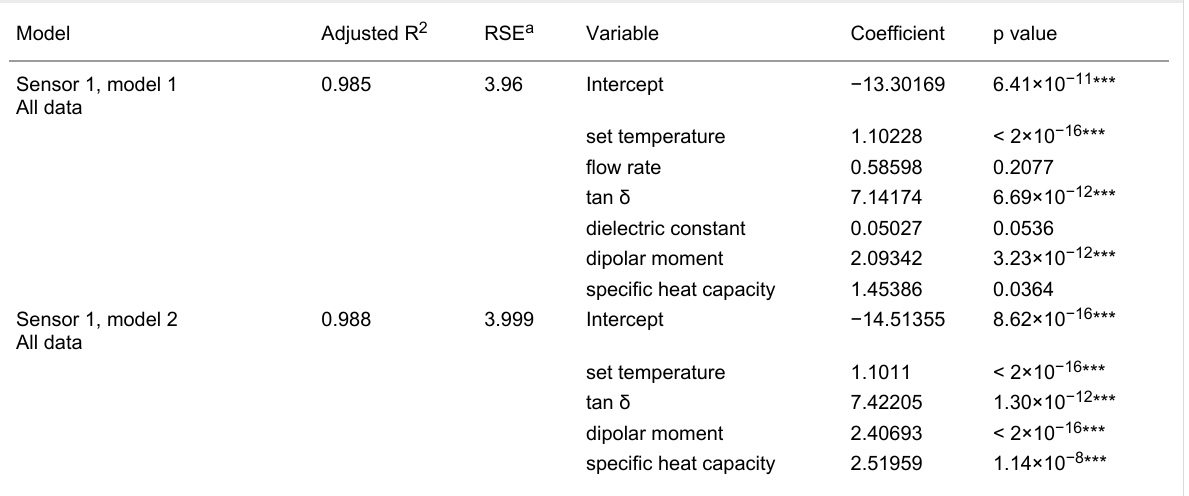
Table 2: Linear multiple regression models for IR sensor